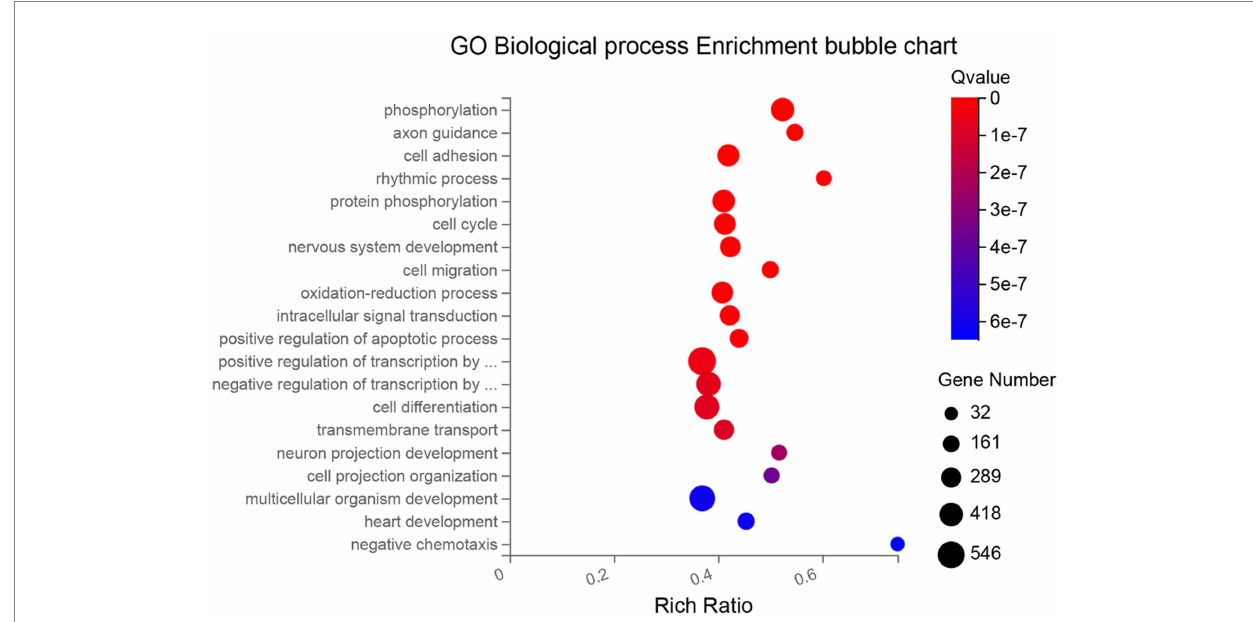
FIGURE 3 Bubble chart of the 20 most significantly enriched biological processes (GO database) between 10 and 59 days in culture. Each process (in the y-axis) is depicted by a bubble, its size represents the number of DEGs annotated to a GO term, and its color shows the enriched significance (Q-value). X-axis represents the enrichment ratio of each process (ratio of the number of enriched genes annotated to the GO term in relation to the total number of genes annotated to that GO term in the species).